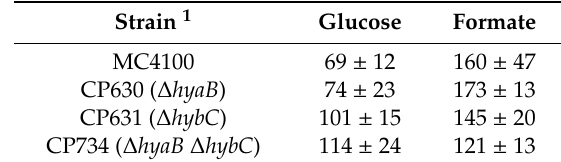
Table 1. H 2 production rates in nmol H 2 · min − 1 · mg − 1 ± standard deviation from at least three independent biological